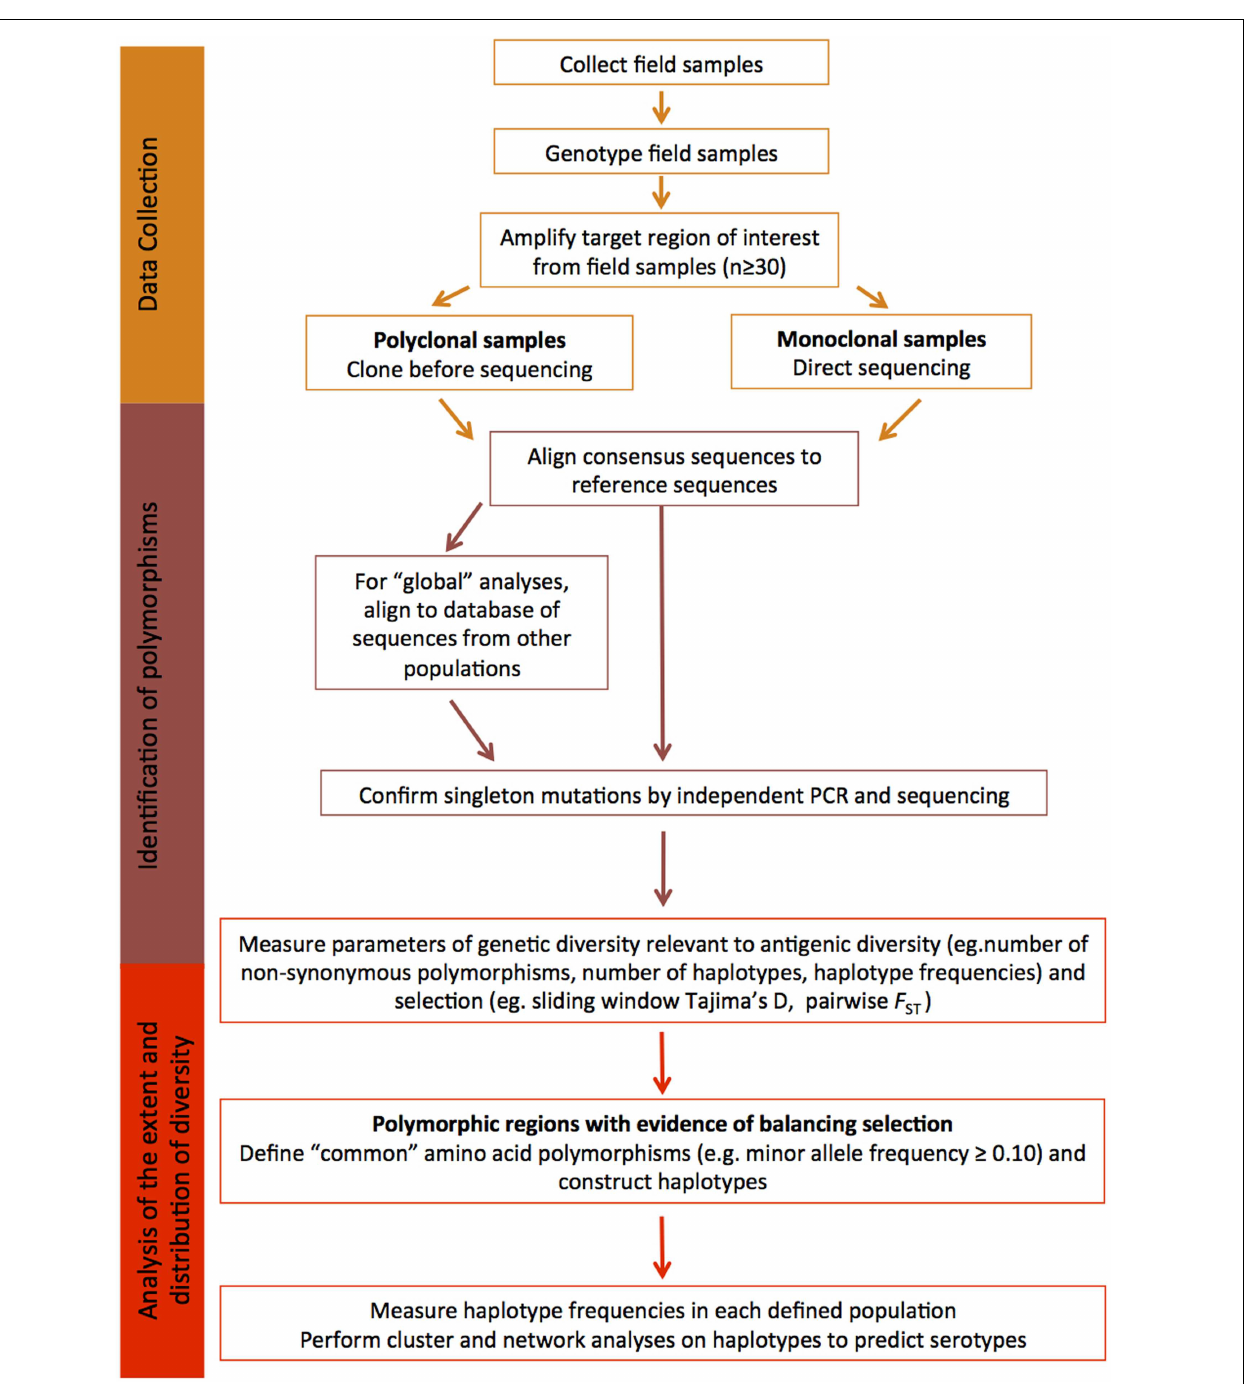
FIGURE 2 | Understanding diversity and predicting serotypes using population genetic analyses . A flow chart describing the step-by-step methodology to define the extent and distribution of parasite diversity and to predict antigenic escape polymorphisms and serotypes (see text for more details).